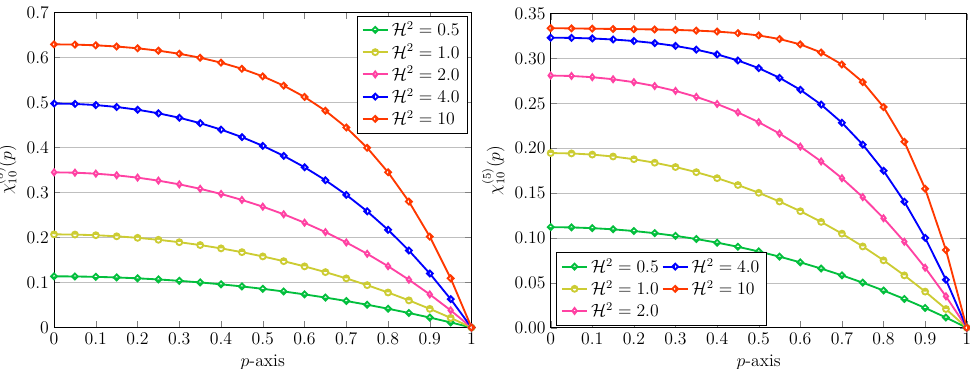
Figure 2. Graphics of numerical solution obtained via QLM-SAPSK approach with δ = 0.5 ( left ) and 2 = 0.5,1,2,4,10, and with integer-orders θ = 2, λ = δ = 2 ( right ) using R = 10, various H